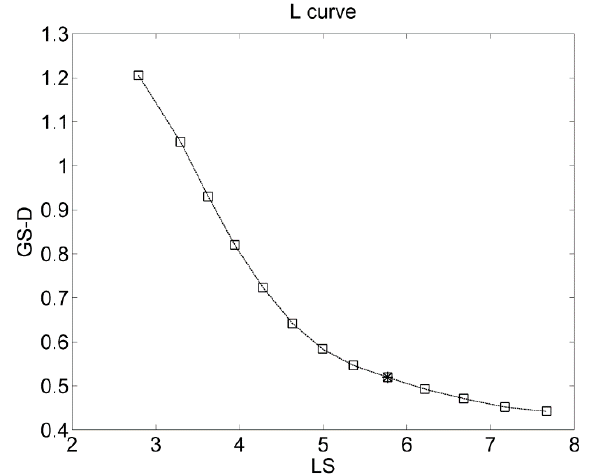
Figure 6. L curve to determine source smoothness. The horizontal axis denotes the modeled source smoothness log p || LS || 2 q , where L and S are defined in Equation (4). The vertical axis denotes source fit to InSAR observations log p || GS ´ D || 2 q , where G and D are defined in Equation (4). The curve is formed by 13 different Laplacian regularized sources S . Each S corresponds to the best-fit result of each inversion. Smoothing strength for the source is controlled by LF in model inversion. There are 13 smoothing factors F range between 10 ´ 4 to 10 ´ 1 with exponential step of 0.25. Note that horizontal axis LS is calculated without multiplying smoothing factor F . The square centered with an asterisk represents that a value of 10 ´ 3 is employed as the smoothing factor for final